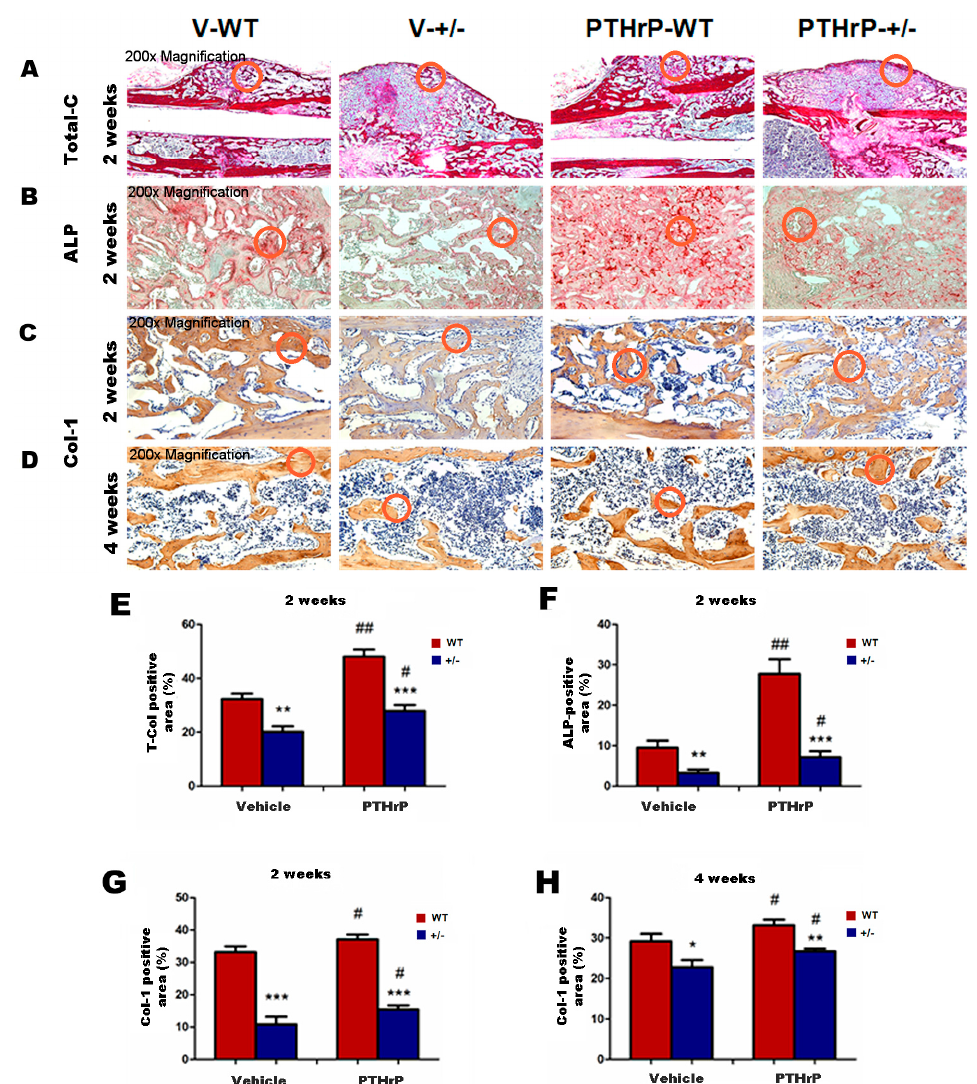
Figure 4. Effects of exogenous PTHrP on osteoblastic bone formation in calluses at two and